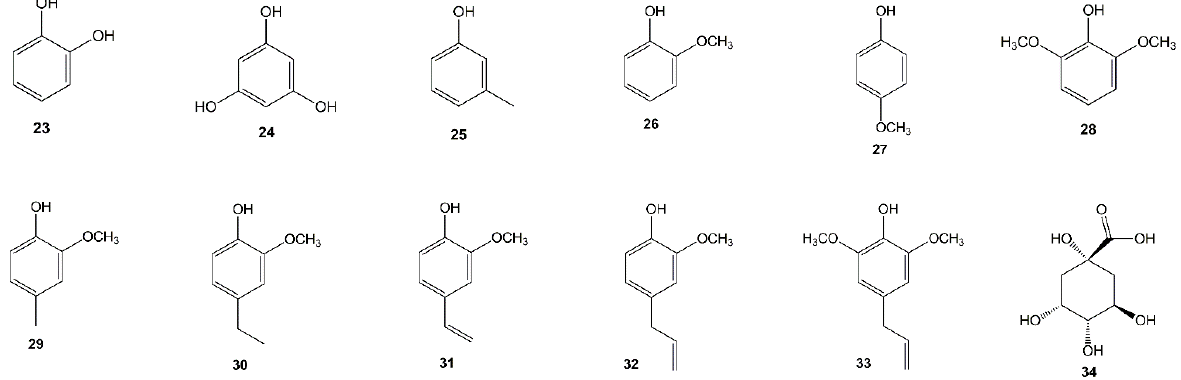
Figure 4. Chemical structure of free phenolic ( 23 – 33 ) and quinic acid ( 34 ) from Uncaria gambir Roxb.